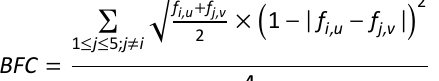
Table 1. Moral conflict matrix representing WFC and BFC. i , j Harm Cheating Betrayal Subversion Degradation Care